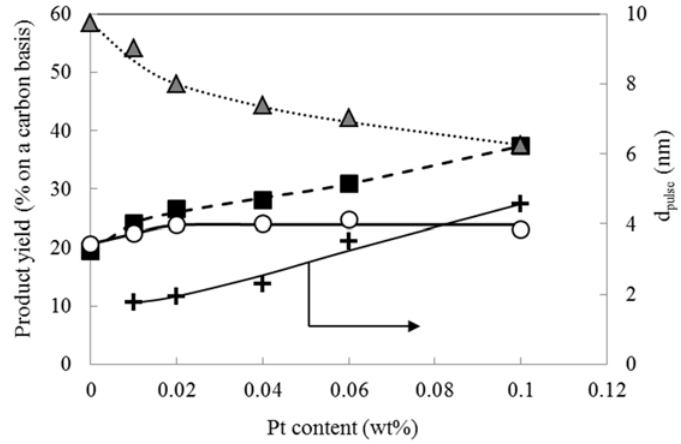
Figure 3. Effect of Pt content on the hydrocracking reaction over Pt-loaded